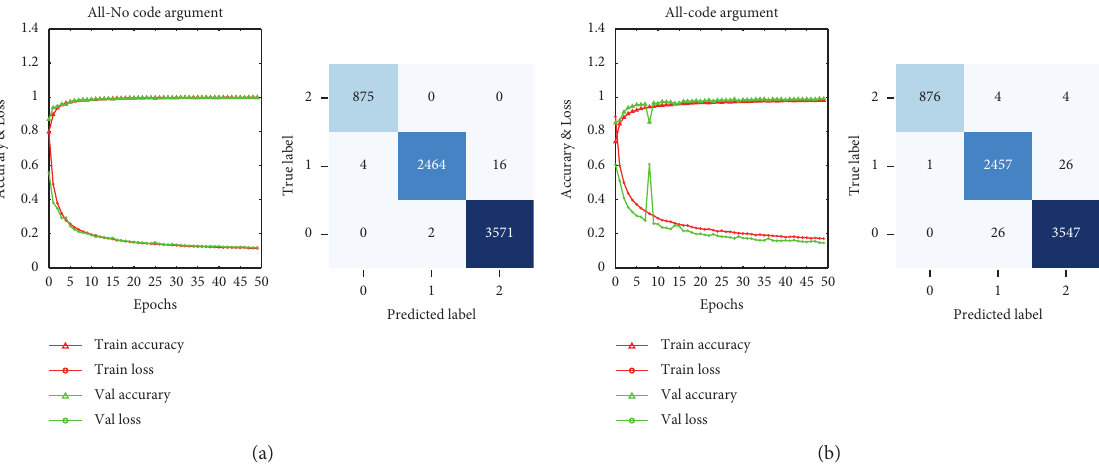
Figure 10: All combined results for (a) image augmentations without code and (b) image augmentations with